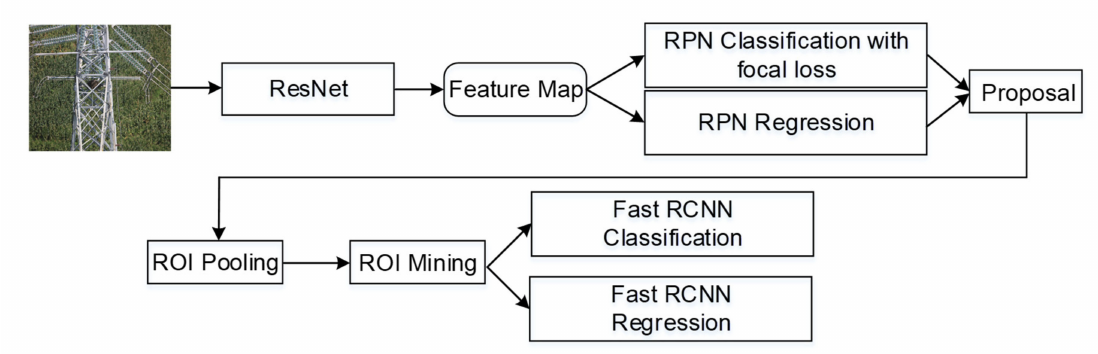
Figure 6. ROI mining faster region-based convolutional neural networks (RCNN) flow